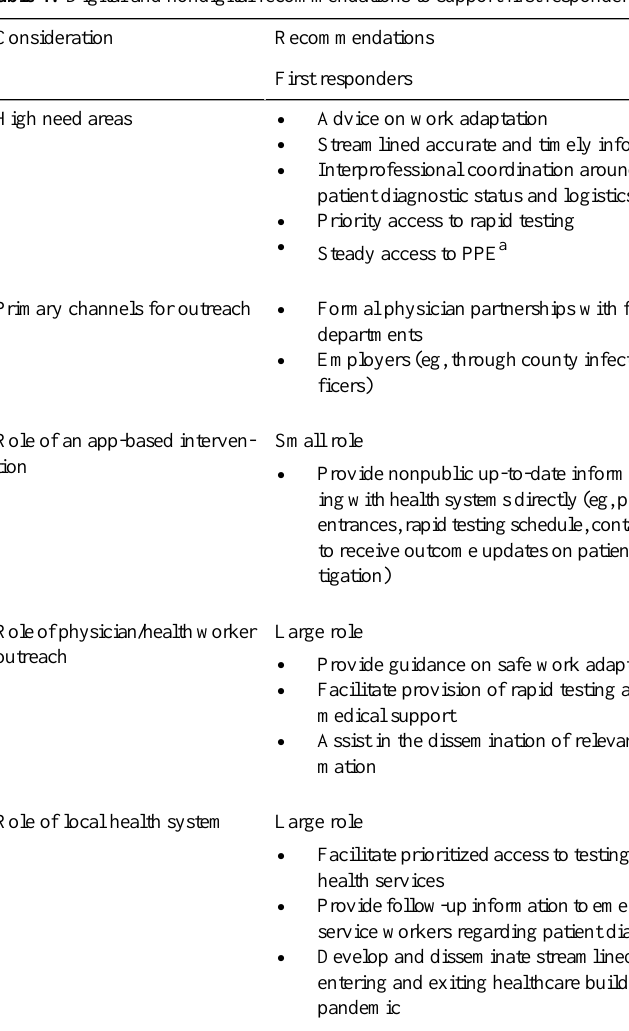
Table 4. Digital and nondigital recommendations to support first responders and essential workers during a